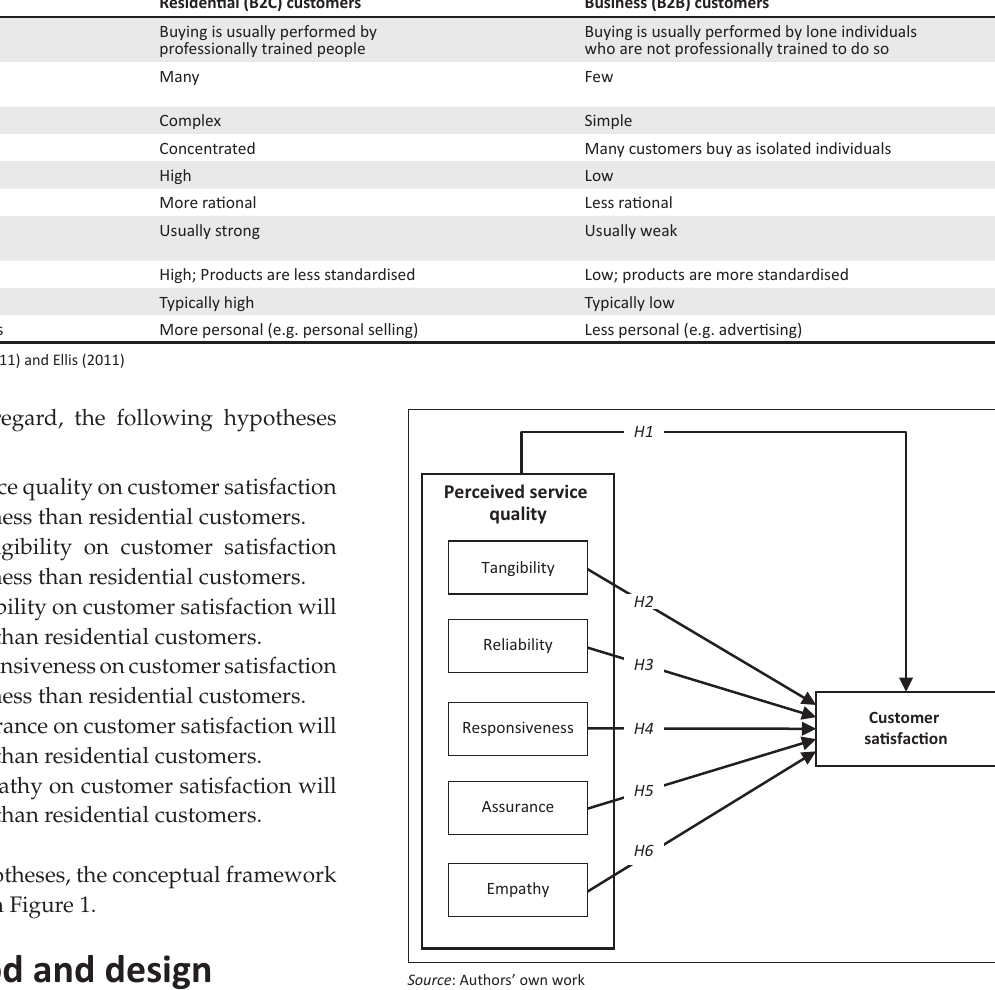
FIGURE 1. Conceptual framework depicting the relationship between the dimensions of service quality and customer